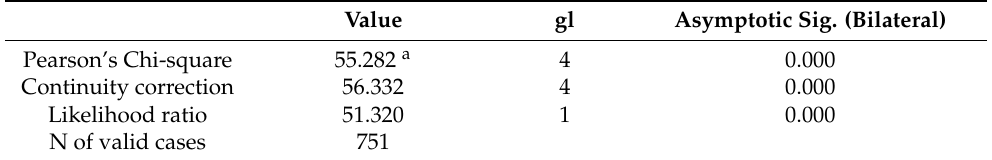
Table A4. Chi-square test